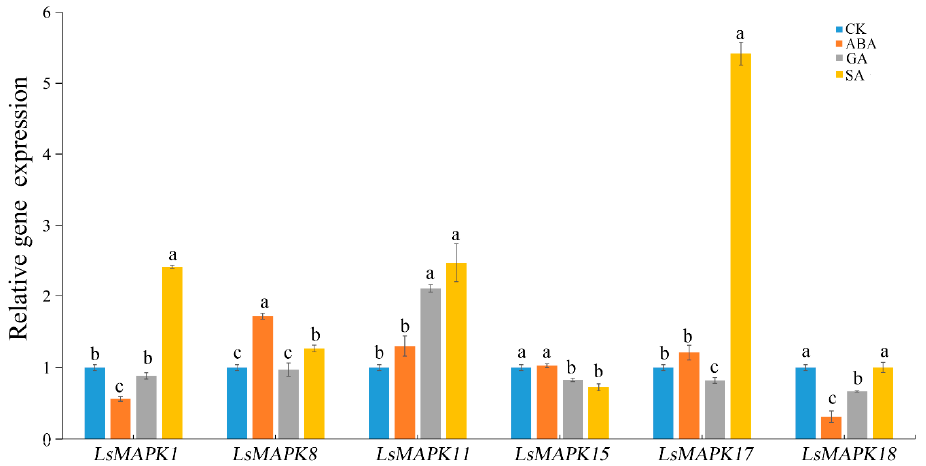
Figure 11. Relative expression of LsMAPK genes under SA (salicylic acid, 0.5 mmol/L), ABA (abscisic acid, 75 µmol/L), GA (gibberellin, 50 µmol/L) and untreated control (CK) at 12 h. Bars with different lowercase letters (a, b, c) represented significantly different by Duncan’s multiple range tests at the 0.05 levels.